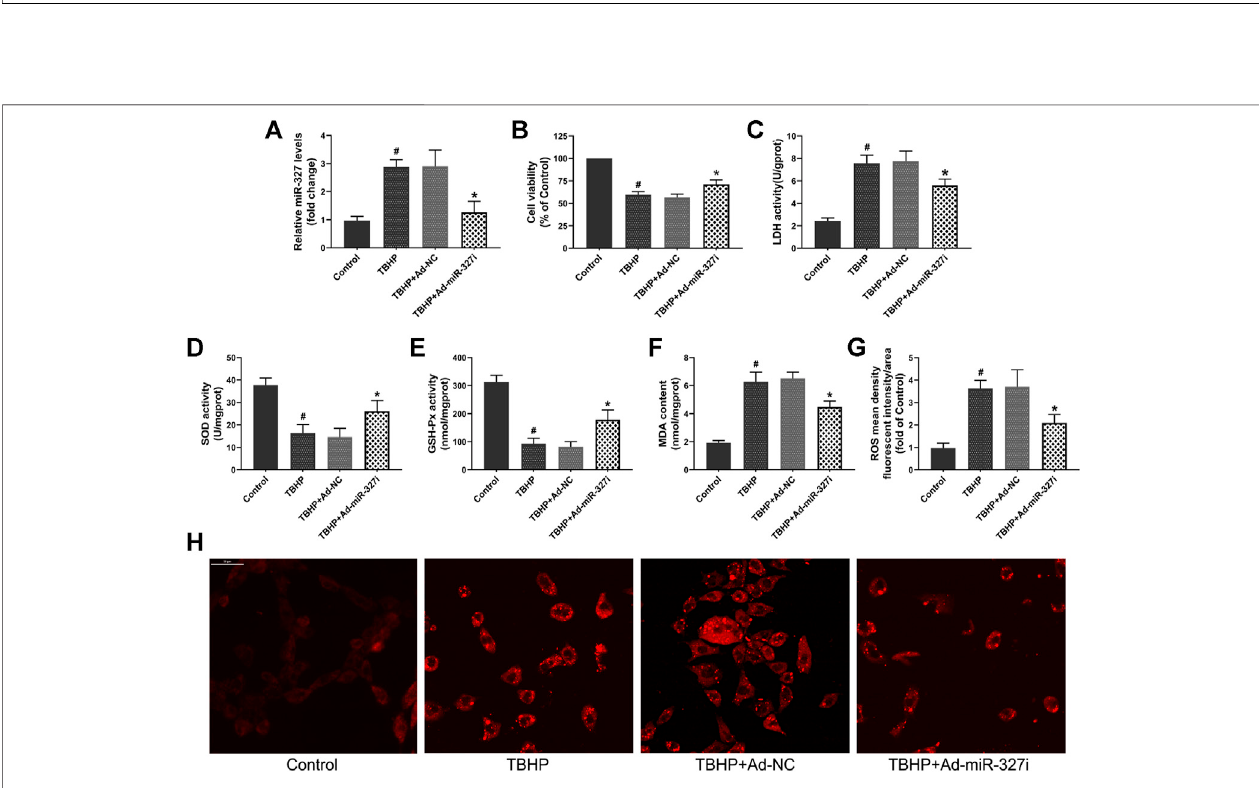
FIGURE 5 | Effects of downregulation of miR-327 on TBHP induced oxidative damage in H9c2 cells. (A) Relative expression of miR-327 in H9c2 cells after 4 h of TBHP treatment. Cell viability (B) and LDH activity (C) were used to evaluate cell damage. The levels of SOD (D) , GSH-Px (E) , and MDA (F) in TBHP-treated H9c2 cells. Representative images of intracellular ROS staining (H) and ROS mean density fl uorescent intensity was analyzed by Image-Pro Plus (G) . Date are expressed as the mean ± SD ( n (cid:2) 4); # p < 0.05 versus the Control group; * p < 0.05 versus the Ad-NC group.